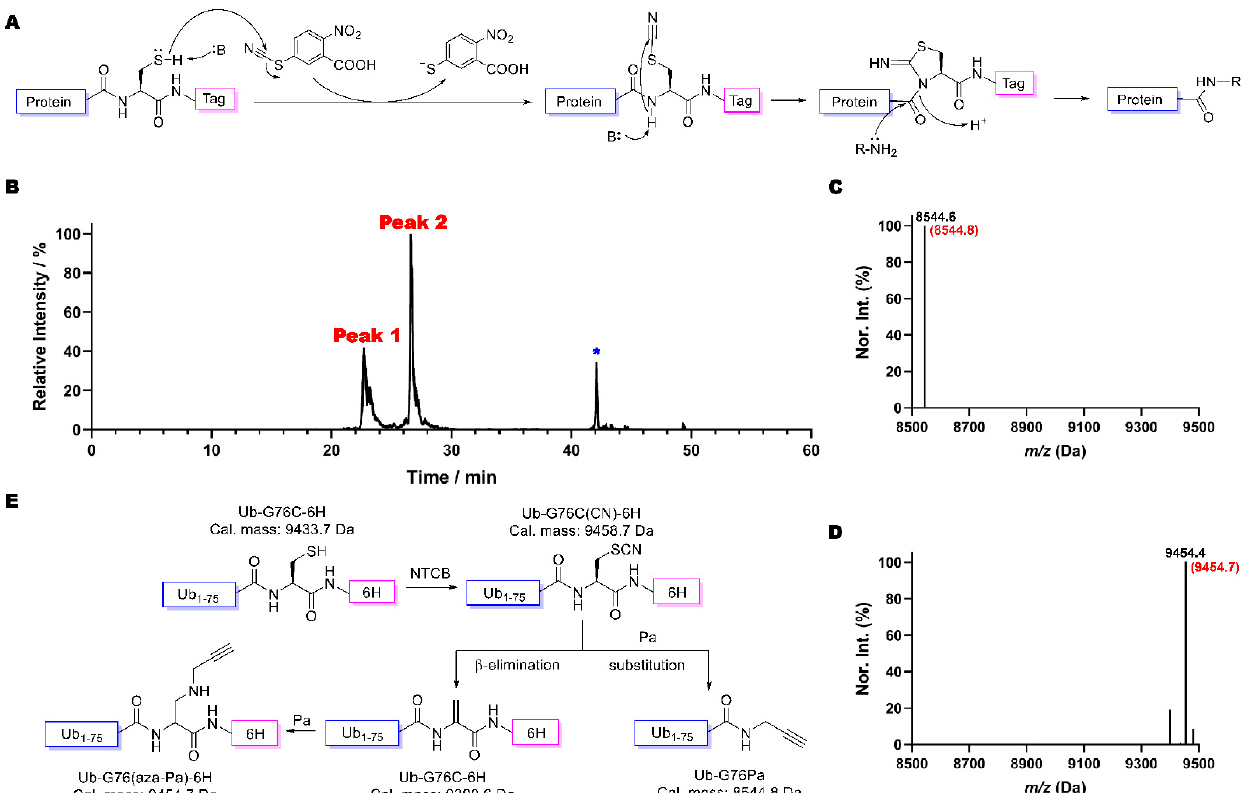
Figure 1. ( A ) Mechanism of ACPL approach using NTCB as a cyanide donor. ( B ) The HPLC chromatogram of products after the ACPL reaction between Ub-G76C-6H and Pa: * indicates the solvent peak. ( C ) The deconvoluted and integrated ESI-MS spectrum of Peak 2 of B . The parenthesized number colored in red is the theoretical molecular weight of the conjugation production of Ub-G76Pa (Pa replaces G76C-6H in Ub-G76C-6H). ( D ) The deconvoluted and integrated ESI-MS spectrum of Peak 1 of B . The parenthesized number colored in red is the theoretical molecular weight of the product in which Pa replaces the thiol group in Ub-G76C-6H. ( E ) A diagram showing two reaction pathways of a cyanylated Ub-G76C-6H product, one undergoing conjugation with Pa and the other undergoing beta elimination to form Dha and then aza-Michael addition with